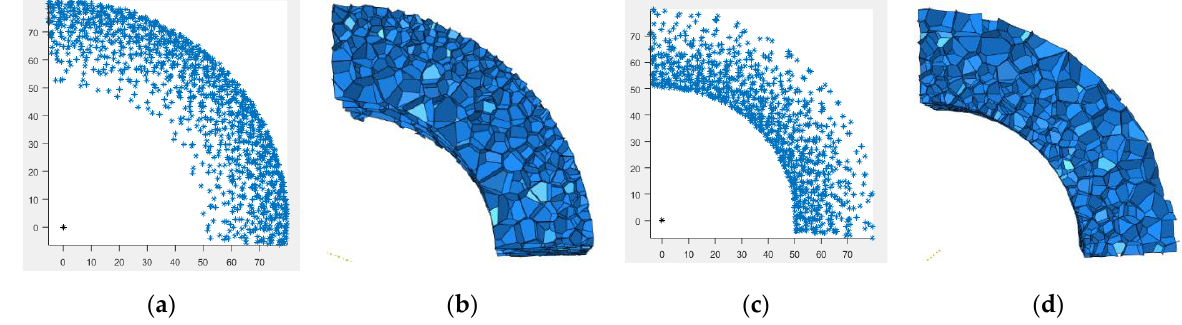
Figure 3. The first polar coordinate 3D-Voronoi modeling process. ( a ) Schematic diagram of P-type nucleation point, ( b ) P-type foam model, ( c ) schematic diagram of N-type nucleation point, and ( d ) N-type foam model.